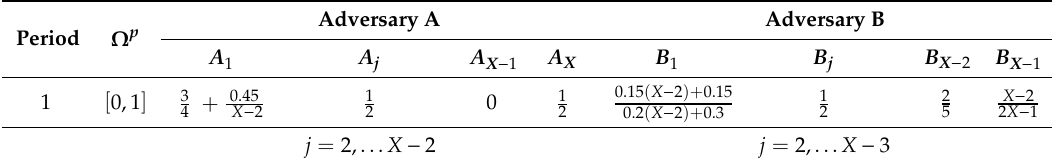
Table 4. Initial probability assessments in generalized complex